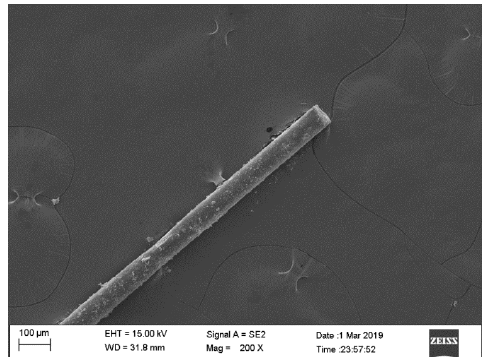
Figure 14. SEM micrographs showing the original morphology of PPF.